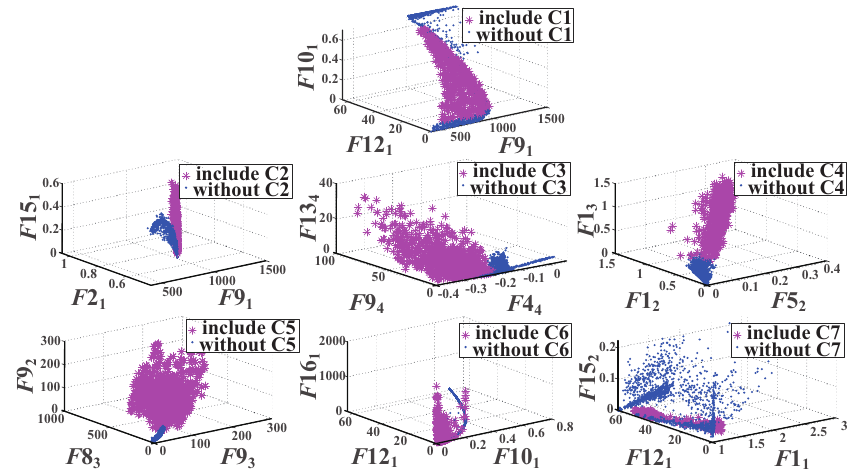
Figure 8. Scatterplot of the top three optimum features for each label in Table